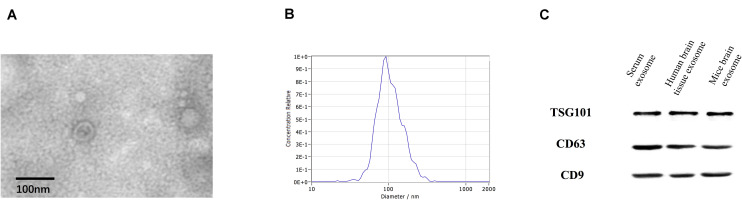
Identification of exosomes. Characterization of exosome-like vesicles by (A) transmission electron microscopy, (B) nanoparticle-tracking analysis (140 ± 19.1 nm) and (C) Western blotting. Presence of the exosomal markers TSG101, CD63, and CD9.